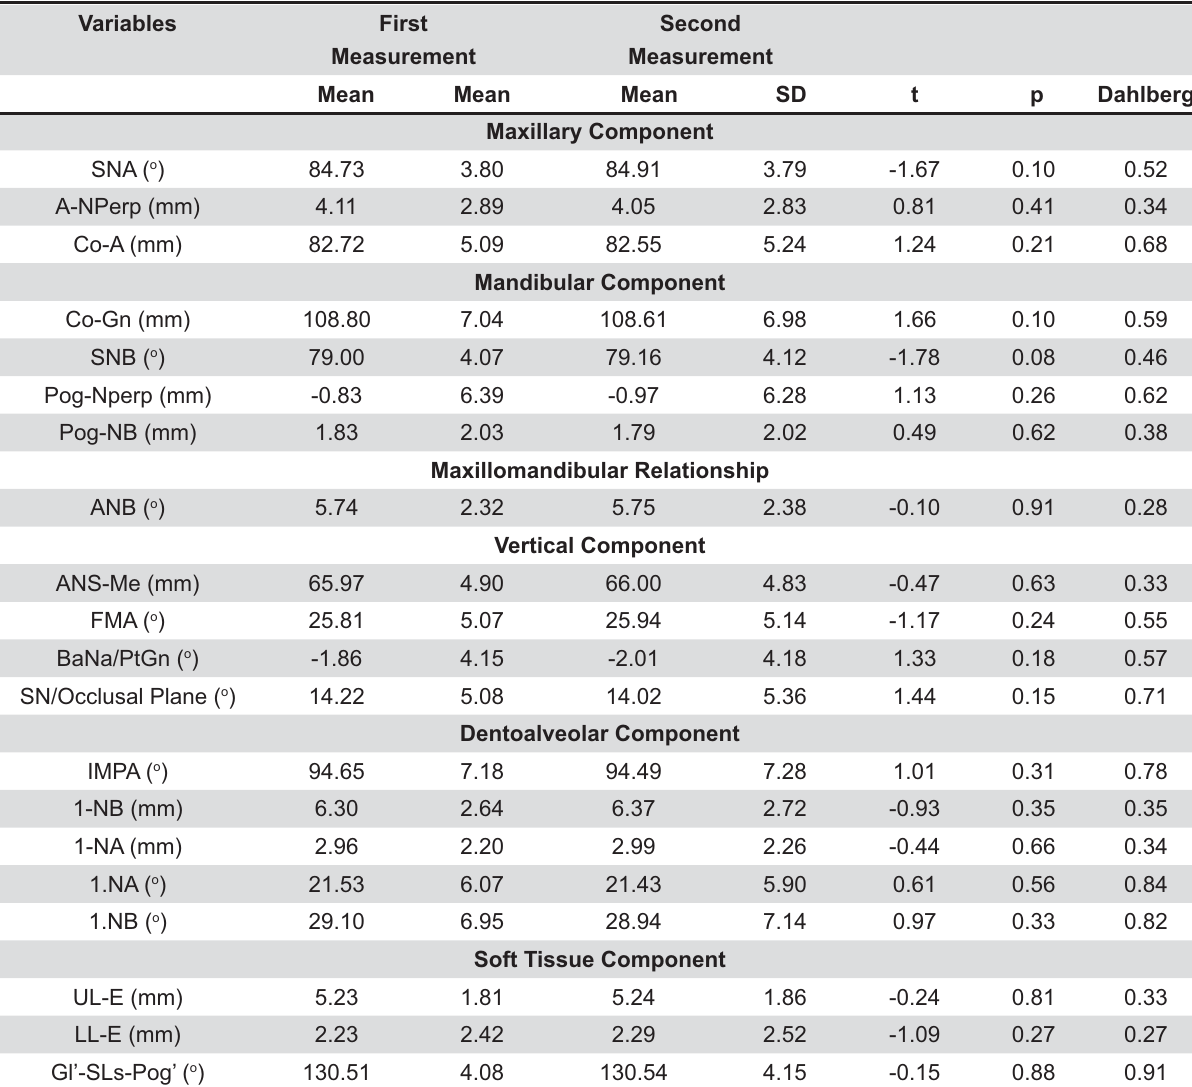
Table 3- Results of systematic and casual errors investigation for lateral cephalograms from cone-beam computed tomography